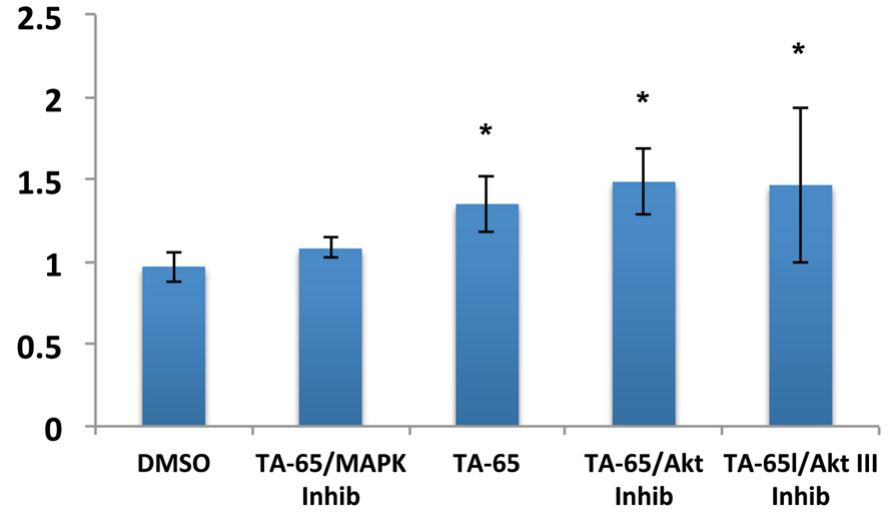
Figure 3. TA-65 activates telomerase via MAPK pathway. CD8 T cells stimulated for a second time and treated with MAPK inhibitor (as described in materials and methods) blocked the increase telomerase activity from TA-65, but no significant inhibition was observed using AKT inhibitors. Statistical significance was determined by student paired t-test ( p <